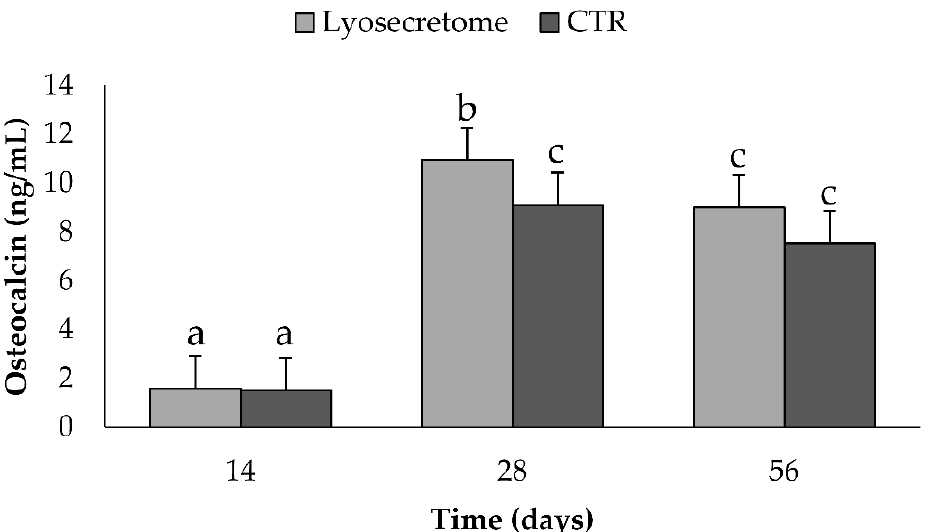
Figure 10. Osteocalcin dosages for samples cultured in osteogenic differentiation medium with Lyosecretome or without (CTR) for 14, 28, and 56 days. Multifactor ANOVA (time and treatment, mean values ± LSD, n = 3) was used. Both time and treatment were significant ( p < 0.0001 and p = 0.0440, respectively). Different letters indicate a significant difference between the means ( p < 0.05), while the same letters indicate no significant difference between the means ( p > 0.05).